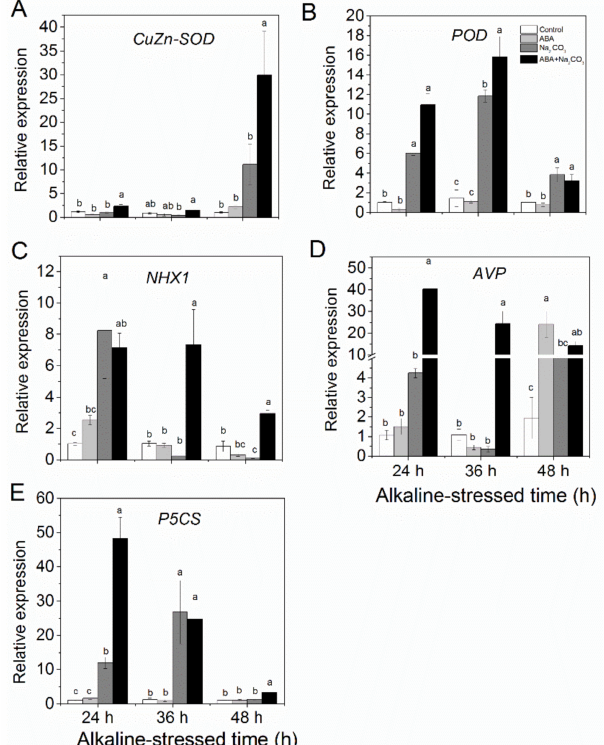
Figure 5. Abscisic acid (ABA) priming upregulated the relative expression of the ion transport genes ( A ) CuZnSOD , ( B ) POD, ( C ) NHX1 , ( D ) AVP , and ( E ) P5CS in alfalfa ( Medicago sativa L.) leaves under alkaline stress. Eighteen-day-old alfalfa seedlings were root-drenched with 10 µ M ABA or without ABA (Control) for 16 h and then exposed to unstressed (Control and ABA) or alkaline-stressed (Na 2 CO 3 and ABA + Na 2 CO 3 , 15 mM Na 2 CO 3 ) conditions. Values are the mean ± standard error, n = 3. Different letters above the columns indicate significant differences (0.05) at each time point based on Duncan’s test. The relative expression levels were analyzed by qRT-PCR and normalized against the internal reference gene Actin 2 , which was stably expressed. The expression levels of unpretreated control (Control) at the indicated times were set as the unit to calculate the expression levels, shown as fold changes relative to the control at the indicated